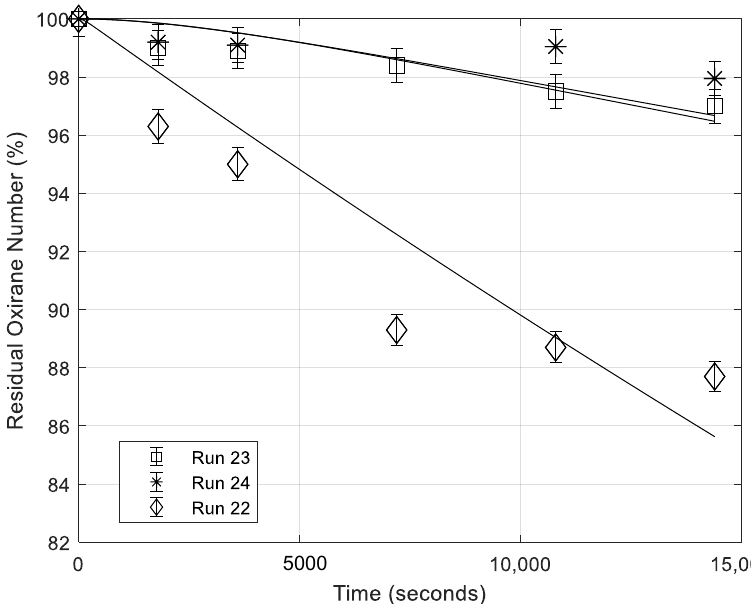
Figure 10. Evolution with time of the residual oxirane number in the presence of HCOOH alone (run 22), at much lower concentration because diluted with water (run 24), in the presence of H 2 O 2 , and performic acid (run 23).